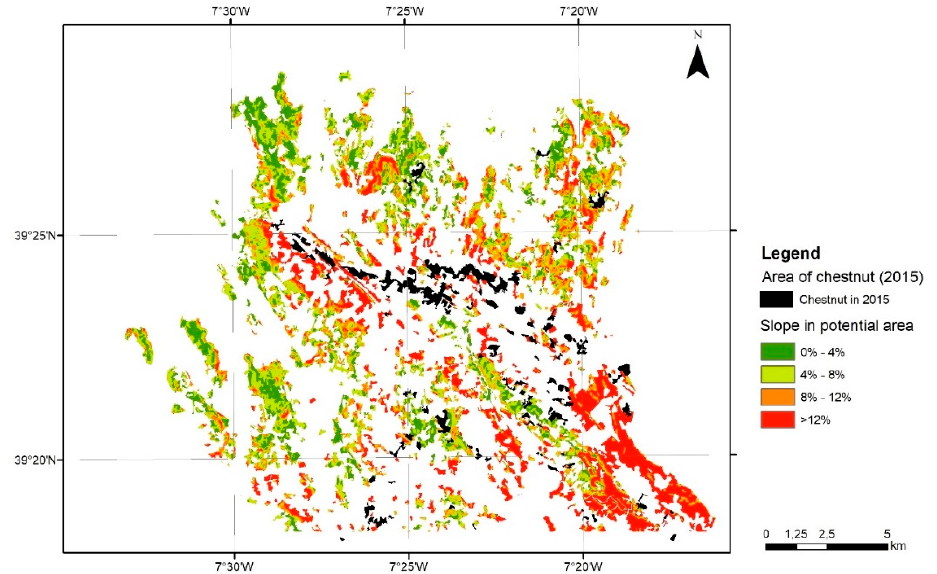
Figure 7. Current chestnut area and distribution of the potential expansion area by slope.